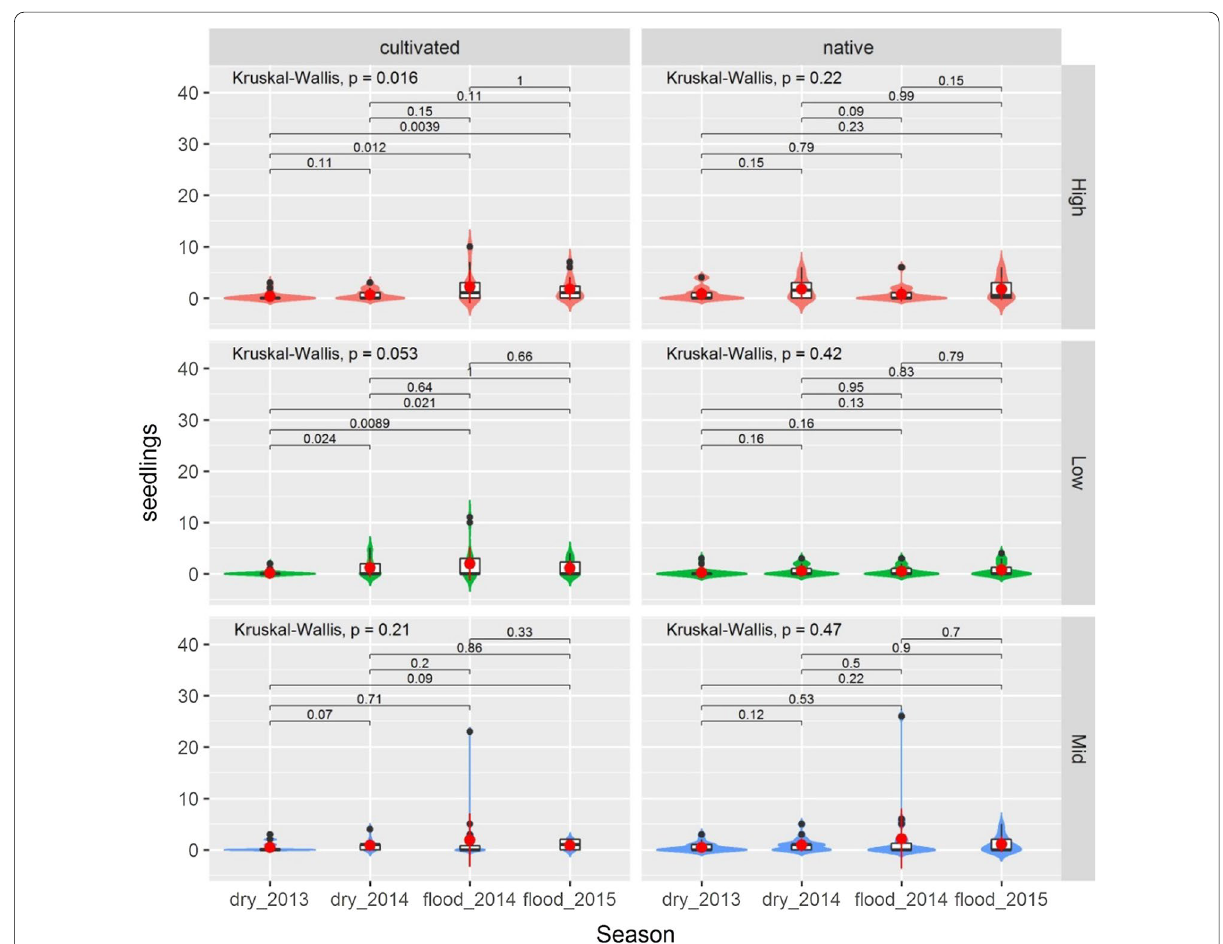
Fig. 4 Differences in number of seedlings between seasonal flood disturbance (post-flood and post-dry disturbance) by type of grasslands (native and cultivated) and topographical gradient (low, mid, high), Pantanal wetland. We classified the topographical conditions into three levels: (1) low– longer duration of flood; (2) mid–intermediate level; and (3) high–short duration of flood. Differences at posteriori analyses are indicated (Dunn test, p <